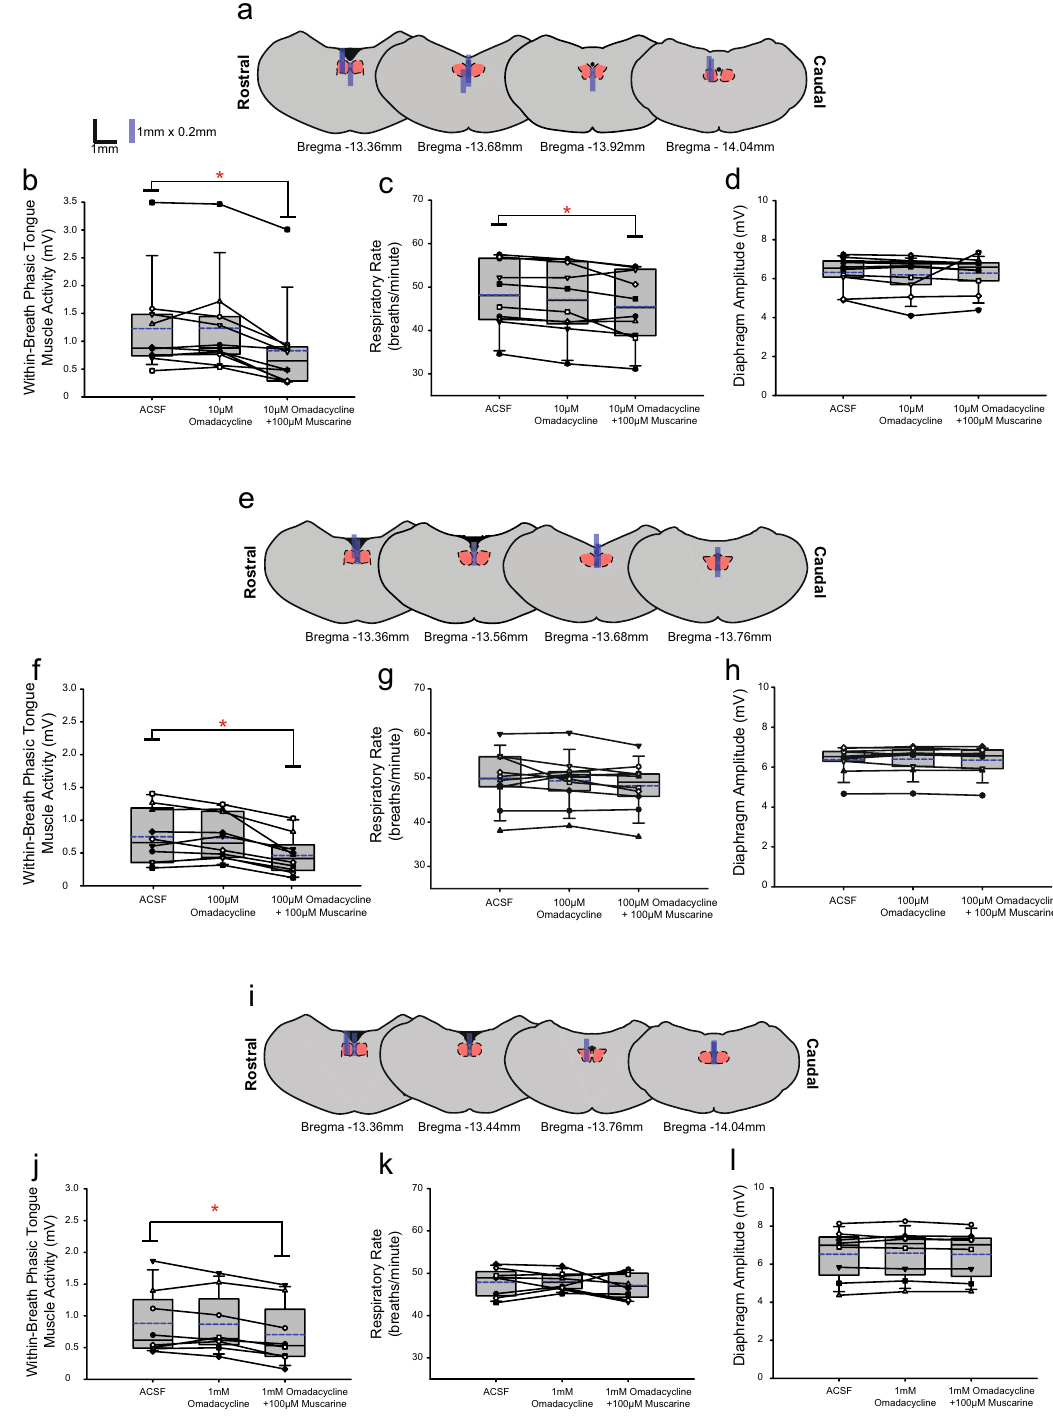
Figure 14. Group data from Protocol 3.2d : Microperfusion of omadacycline into the HMN with and without co-application of muscarine (top panels: 10 µM, n = 10; middle panels: 100 µM, n = 10; bottom panels: 1 mM, n = 8). Schematic representations of coronal sections of medulla illustrating the distribution of probe sites across all experiments ( a , e , i ). Drawn to scale, the blue rectangles represent reconstruction of the sites of the microdialysis probes; overlap obscures some of the individual probe sites. Box and whisker plots show individual and group data (median [dashed line], mean [solid line] and 25th and 75th percentiles) for within- breath phasic tongue muscle activity ( b , f , j ), respiratory rate ( c , g , k ), and diaphragm amplitude ( d , h , l ). Each animal is indicated by a different symbol. *, indicates p < 0.05 compared to baseline ACSF